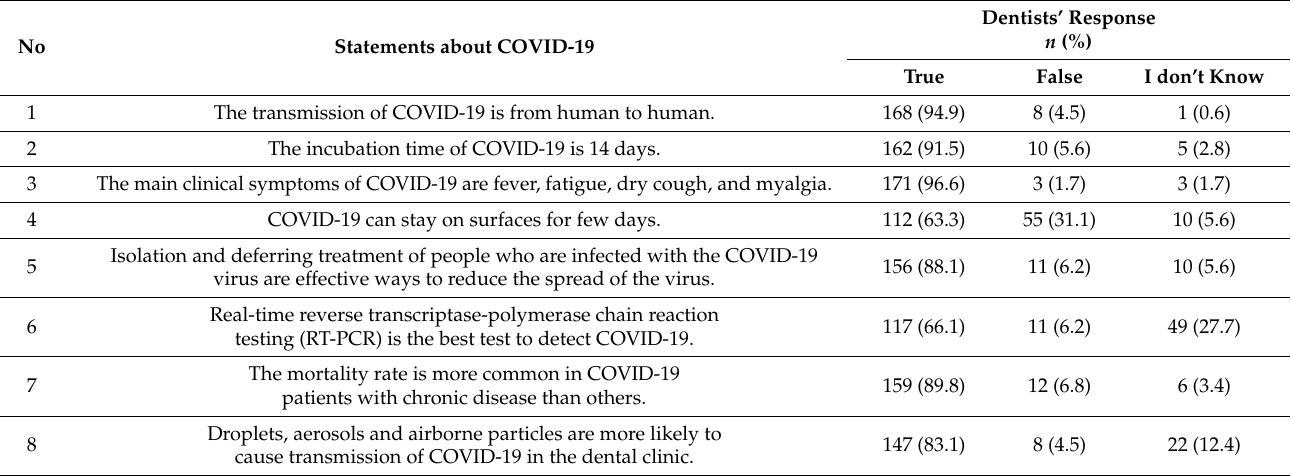
Table 2. Awareness of participating dentists of COVID-19 (No =